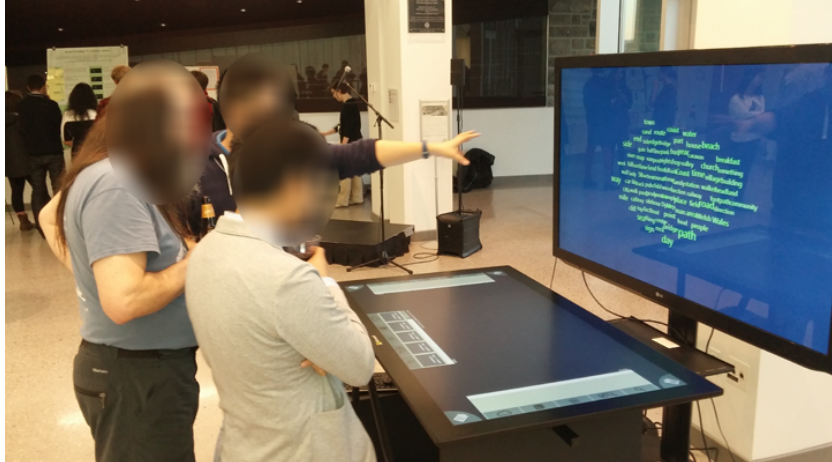
Figure 6. A1 uses the BlogCloud to reflect on his own blogs. The visualization shows a word cloud of blog